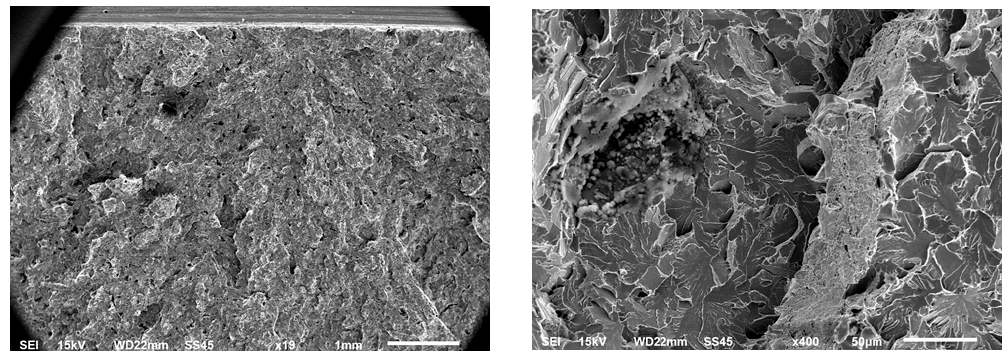
( b ) Fracture surfaces of Charpy impact testing at − 50 °C. Figure 12.